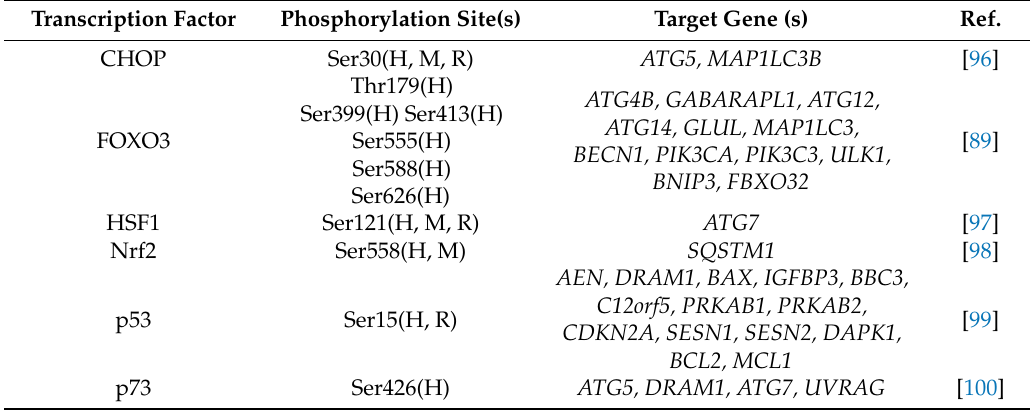
Table 2. Transcriptional regulation of autophagy through AMPK phosphorylation. H, human; M, mouse; R,